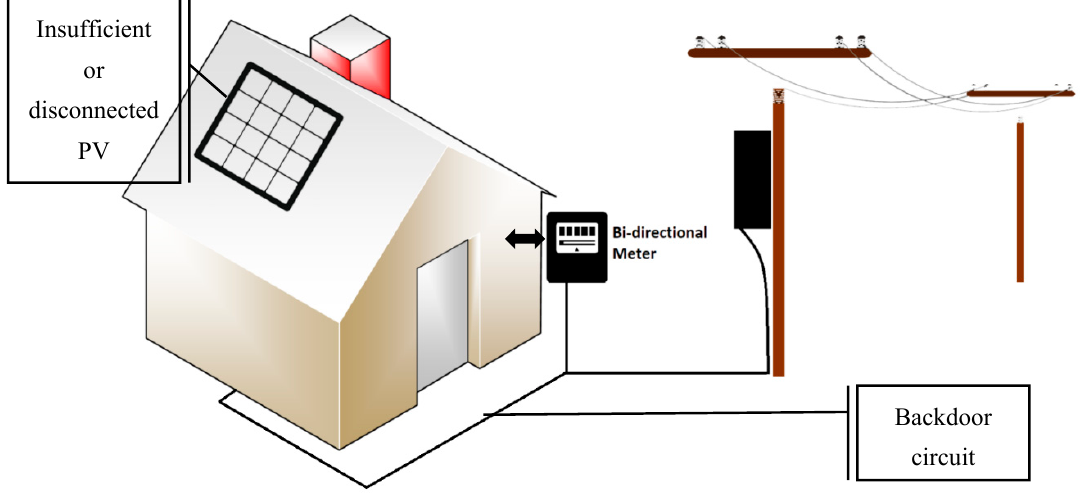
Figure 15. Illustration of energy fraud through energy selling.